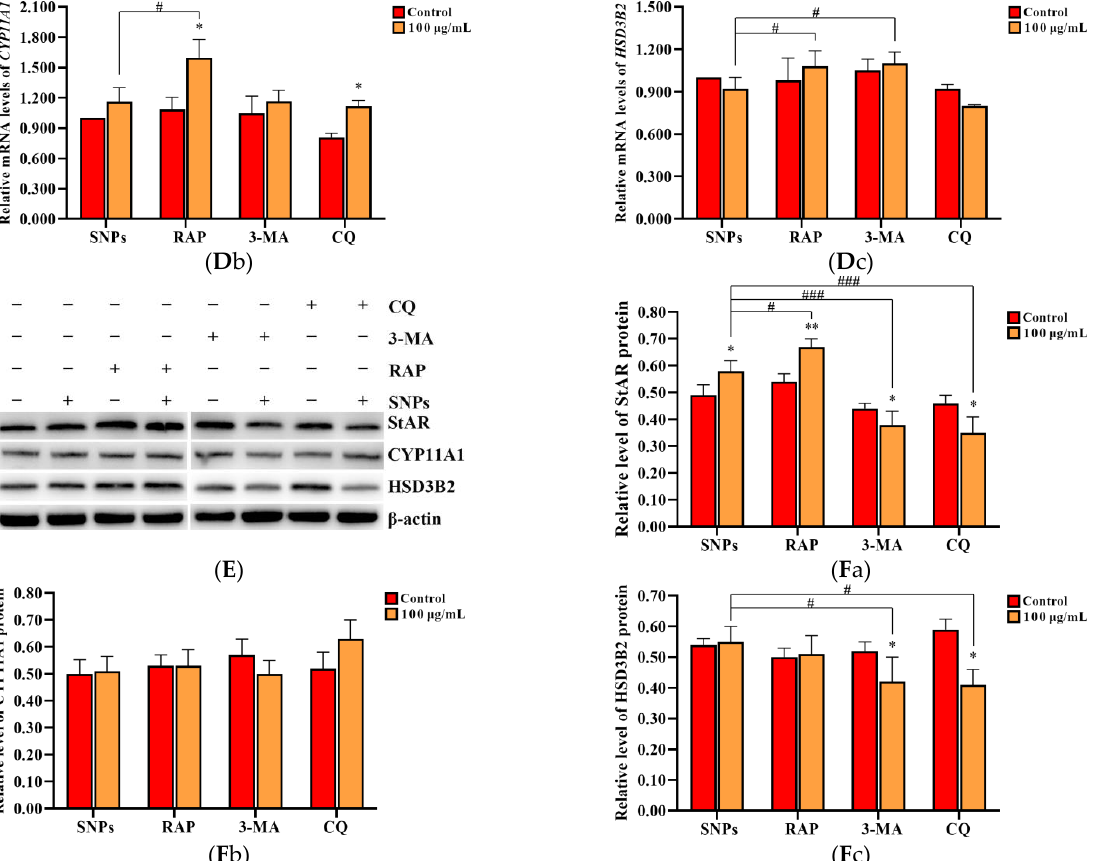
Figure 6. Effect of SNP-activated autophagy on testosterone secretion in PLCs. ( A ) Determination of BECLIN-1, P62, and LC3-II protein levels in PLCs via Western blot analysis. ( B ) Quantification of the band intensity in A is presented as the relative ratio of BECLIN-1 ( B a), P62 ( B b), and LC3-II ( B c) to β -actin. ( C ) Detection of the concentration of testosterone via ELISA analysis in the PLC culture supernatant. ( D ) Measurement of StAR ( D a), CYP11A1 ( D b), and HSD3B2 ( D c) mRNA levels in PLCs via qRCR analysis. ( E ) Determination of the levels of StAR, CYP11A1, and HSD3Β2 in PLCs via Western blot analysis. PLCs were exposed to 100 µg/mL SNPs for 12 h before exposure to 0.2 µM 3-MA, 5 µM CQ, and 1 µM RAP for 6 h. ( F ) Quantification of the band intensity in E is presented as the relative ratio of StAR ( F a), CYP11A1 ( F b), and HSD3Β2 ( F c), respectively, to β -actin. Data are presented as the mean ± SEM of three independent experiments. * Statistically different from the control (* p < 0.05, ** p < 0.01, and *** p < 0.001); # statistically different from the SNP group ( # p < 0.05, ## p < 0.01, and ### p < 0.001).